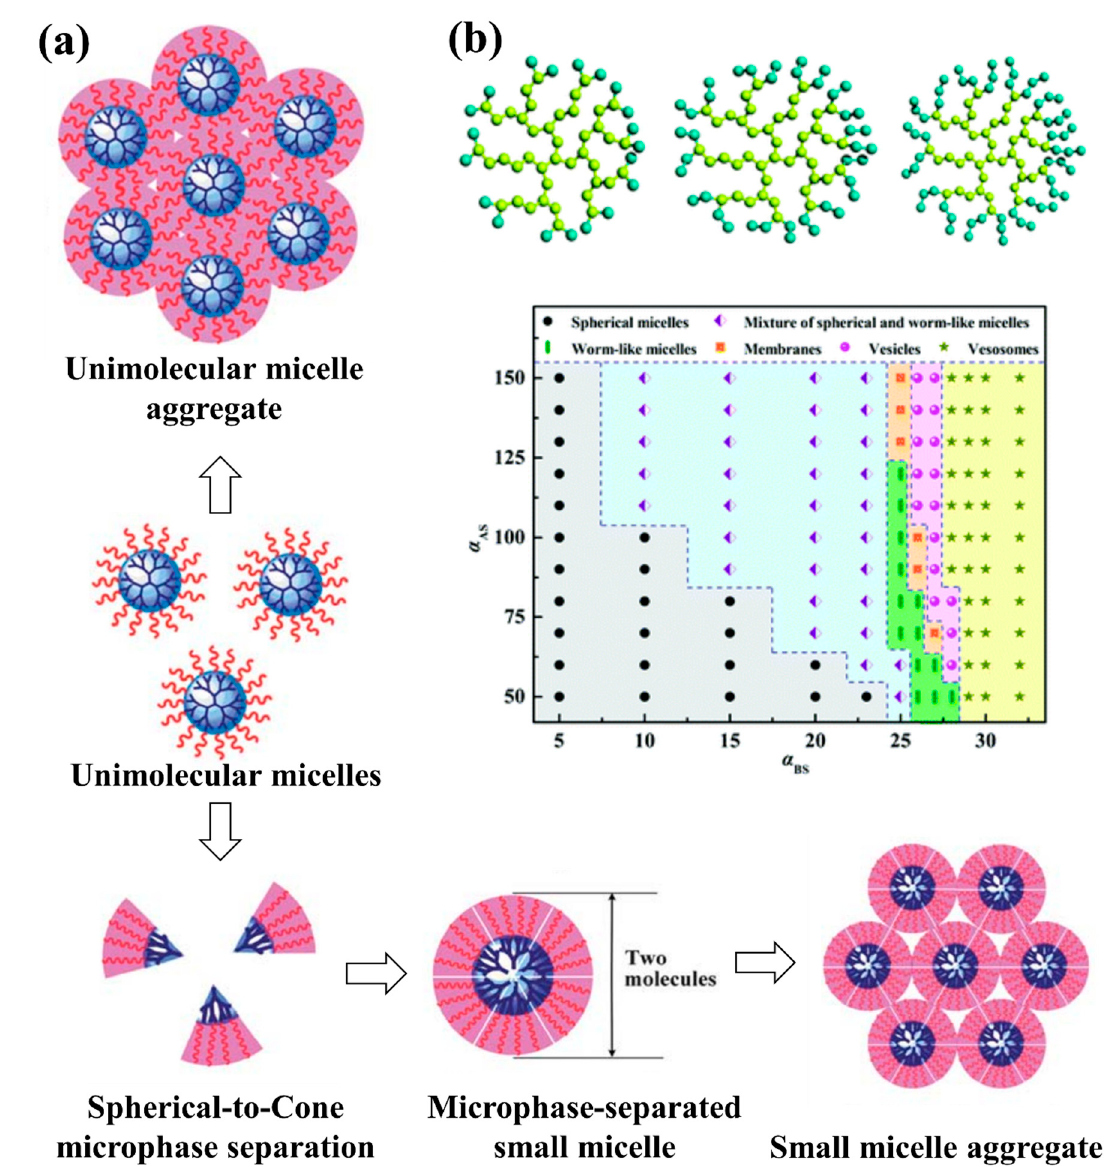
Figure 3. ( a ) Self-assembly mechanism of the microphase separated small micelle with a spherical-to-cone microphase separation [148] and inset ( b ) morphological phase diagram of aggregates formed from A 42 B 20 in selective solvents as a function of the interaction parameters. A bead is hydrophobic and B bead is hydrophilic [149].